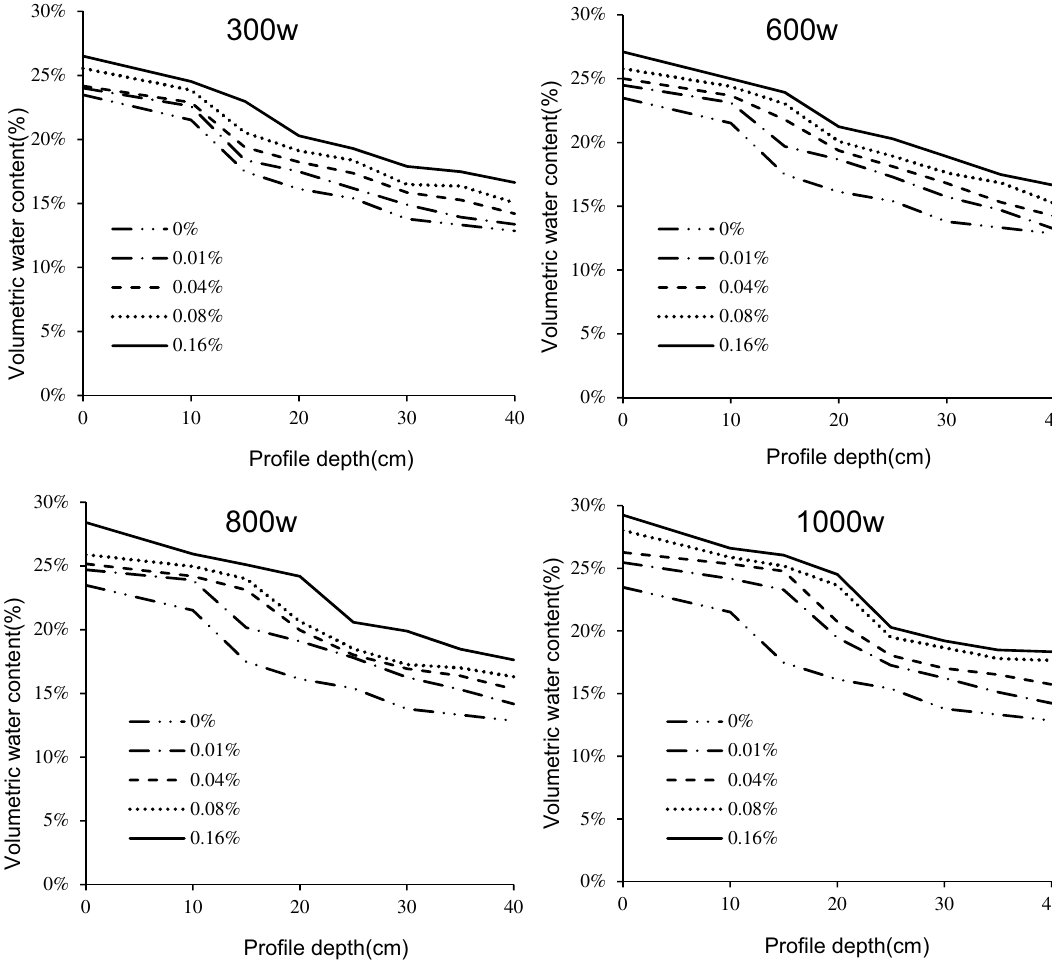
Figure 6. Volumetric water content of iron tailings profile for four molecular weight (300w, 600w, 800w and 1000w) and five mass concentration (0%, 0.01%, 0.04%, 0.08% and 0.16%) of